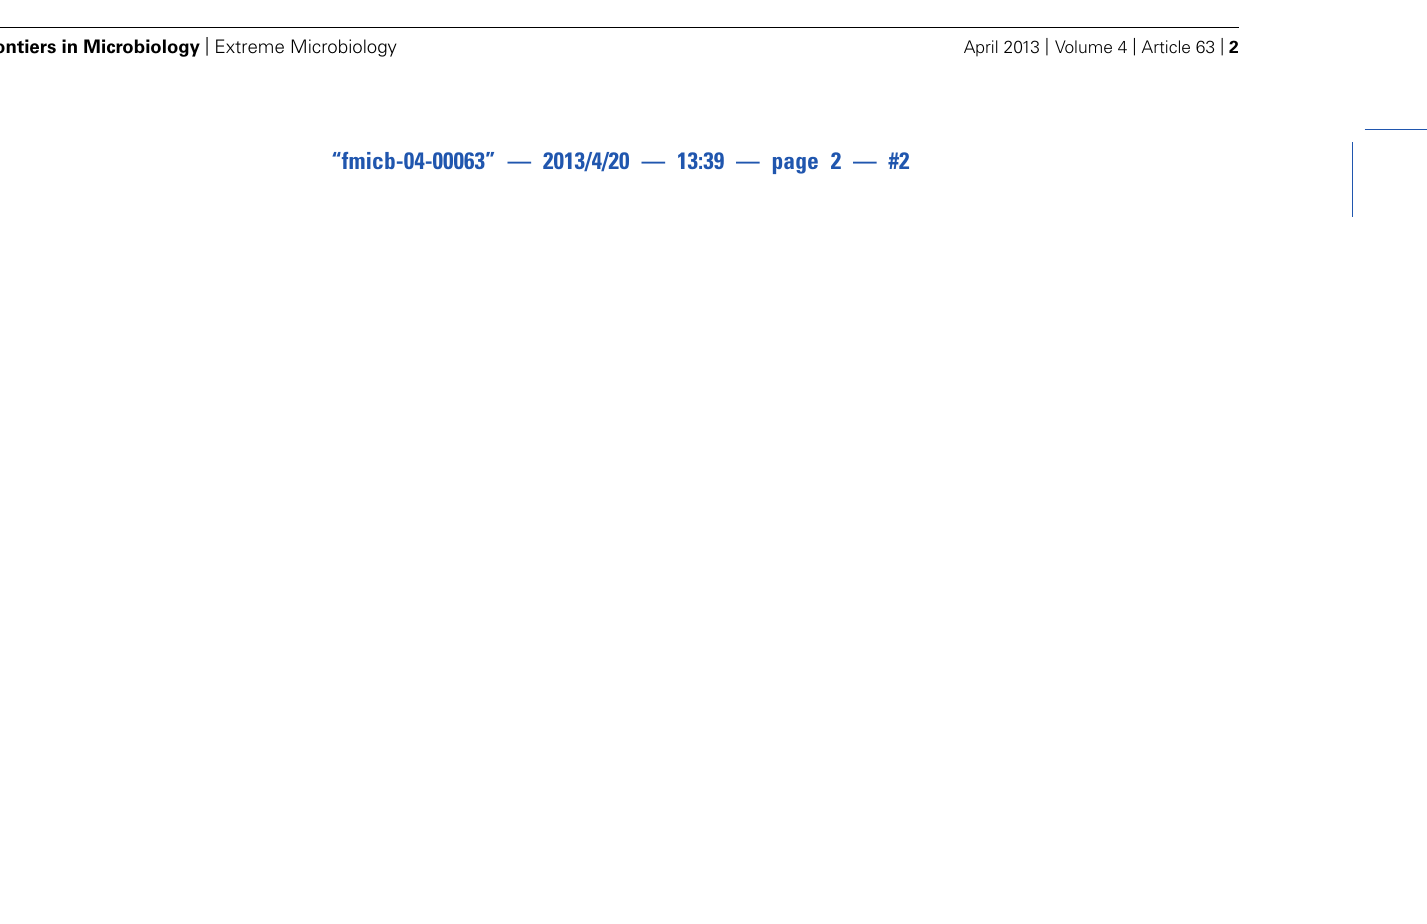
Frontiers in Microbiology | Extreme